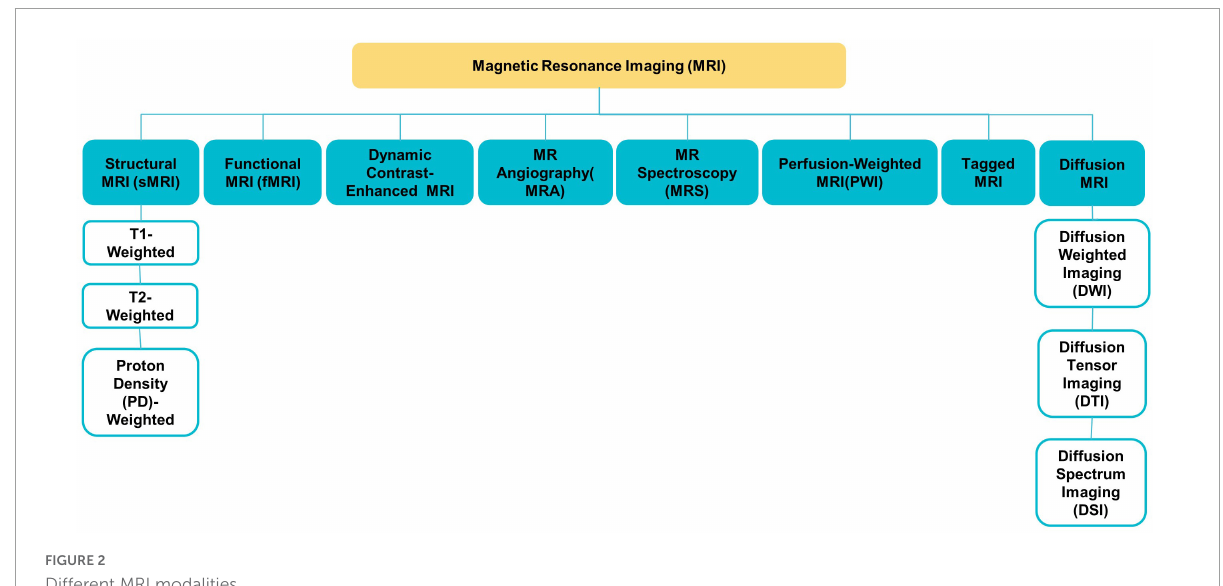
FIGURE2 Different MRI